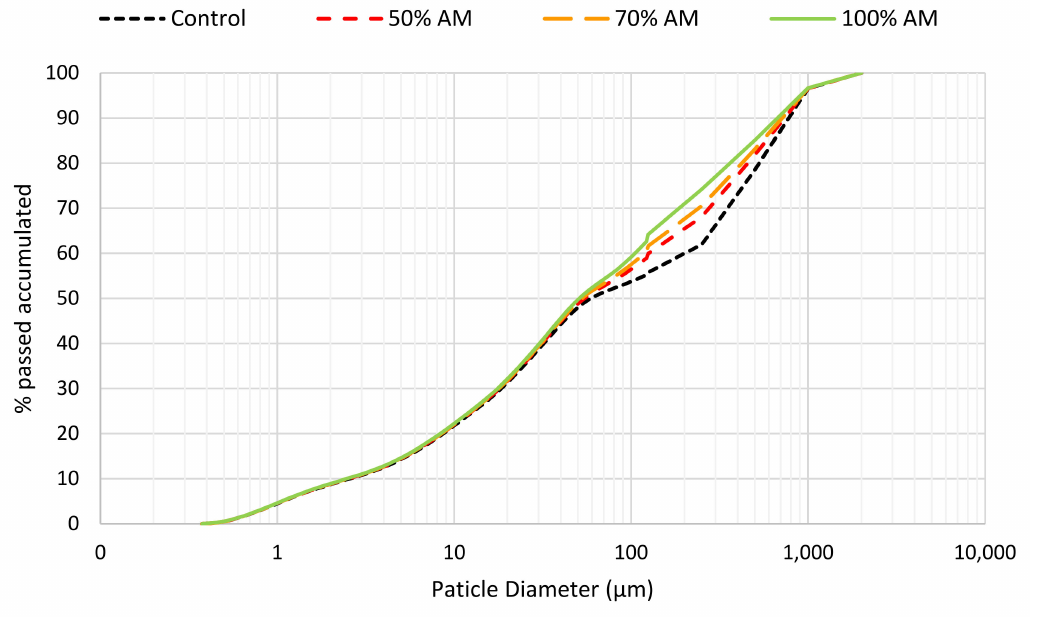
Figure 3. Grading curves of UHPFRC.